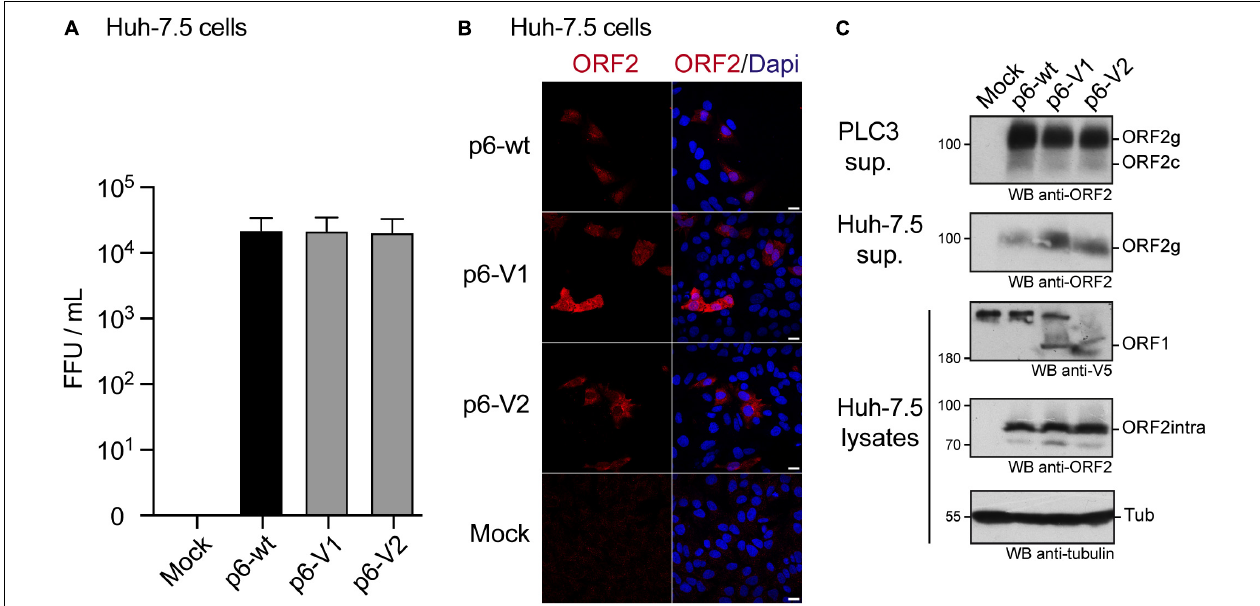
FIGURE 6 | Infection of Huh-7.5 cells by HEV p6 expressing V5-tagged ORF1 polyprotein. (A) Infectious titers of HEV p6 expressing epitope-tagged ORF1 polyprotein. Ten dpe, supernatants of PLC3 cells electroporated with p6-wt, p6-V1 or p6-V2 were collected to infect Huh-7.5 cells. Three days post-infection, Huh-7.5 cells were fixed and stained with an anti-ORF2 antibody (1E6). The number of ORF2-positive cells from three independent experiments were counted and used to calculate infectious titers in focus forming unit (FFU/mL). Statistical analysis was performed using the Mann–Whitney test. (B) Immunofluorescence of HEV p6-infected Huh-7.5 cells. Huh-7.5 cells were infected with the supernatants of PLC3 cells that were electroporated with HEV p6 expressing non-tagged ORF1 (p6-wt) or V5-tagged (p6-V1, p6-V2) replicase as mentioned above. Three days post-infection, cells were processed for anti-ORF2 immunofluorescence (1E6, red) prior to analysis by confocal microscopy. Cell nuclei were stained with Dapi (blue). Huh-7.5 cells infected with mock-electroporated PLC3 cell supernatant served as negative control (Mock). Scale bar = 20 µ m. (C) Expression of epitope-tagged ORF1 and ORF2 proteins in the p6 cell culture system. PLC3 cells were electroporated with p6-wt, p6-V1 or p6-V2. Ten dpe, total protein extracts were submitted to Western blot and probed with an anti-ORF2 antibody (1E6, first panel, PLC3 sup.). Huh-7.5 cells were infected with PLC3 supernatants. Three days post-infection, Huh-7.5 supernatants were also analyzed for ORF2 expression (1E6, second panel, Huh-7.5 sup.). In parallel, Huh-7.5 cells were lysed and total protein extracts were probed with anti-V5, -ORF2 (1E6) and - γ -tubulin antibodies (last three panels, Huh-7.5 lysates). Molecular weight markers are indicated in kilodaltons. ORF1, full-length protein; ORF2g, glycosylated form of ORF2; ORF2c,